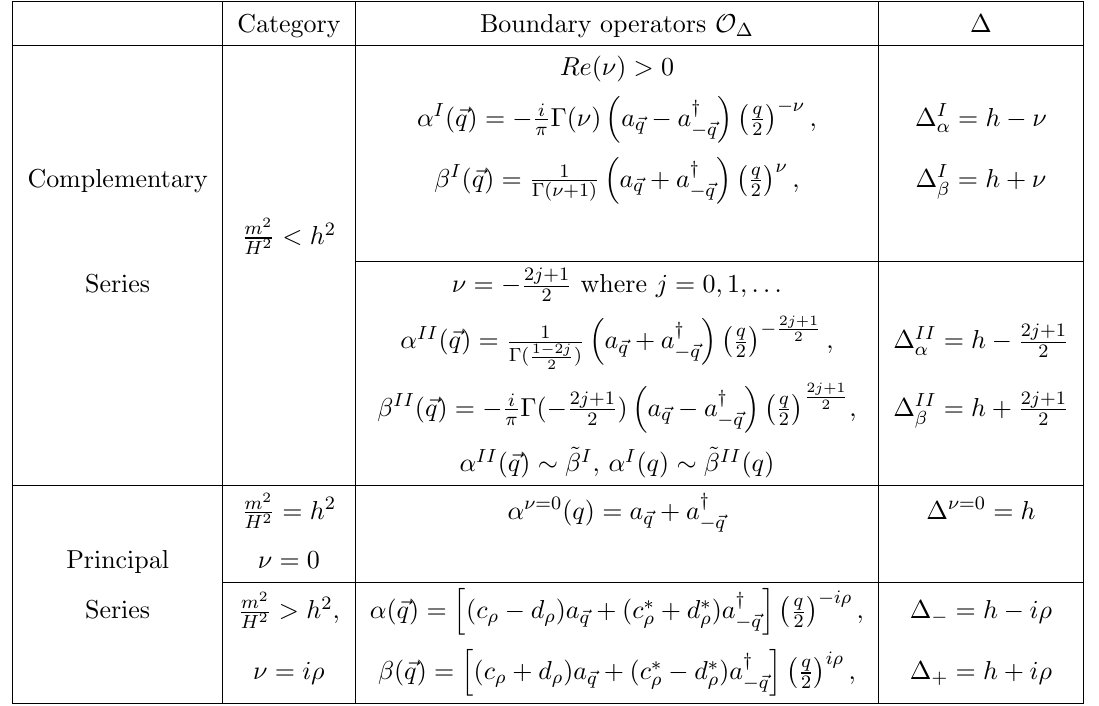
Table 2 . Late time boundary operators. We have categorized the solutions among Complementary Series into two branches, and these branches are related to each other by a shadow transformation, denoted by a tilde. In the table (cid:23) 2 = h 2 (cid:0) m 2 where by (cid:23) and (cid:26) we denote the positive root. H 2 The scaling weight for the operators on the de Sitter late time boundary are: for (cid:11) , c (cid:11) = (cid:0) (cid:23) and Re ( c (cid:11) ) < 0 while for (cid:12) , c (cid:12) = + (cid:23) and Re ( c (cid:12) ) >